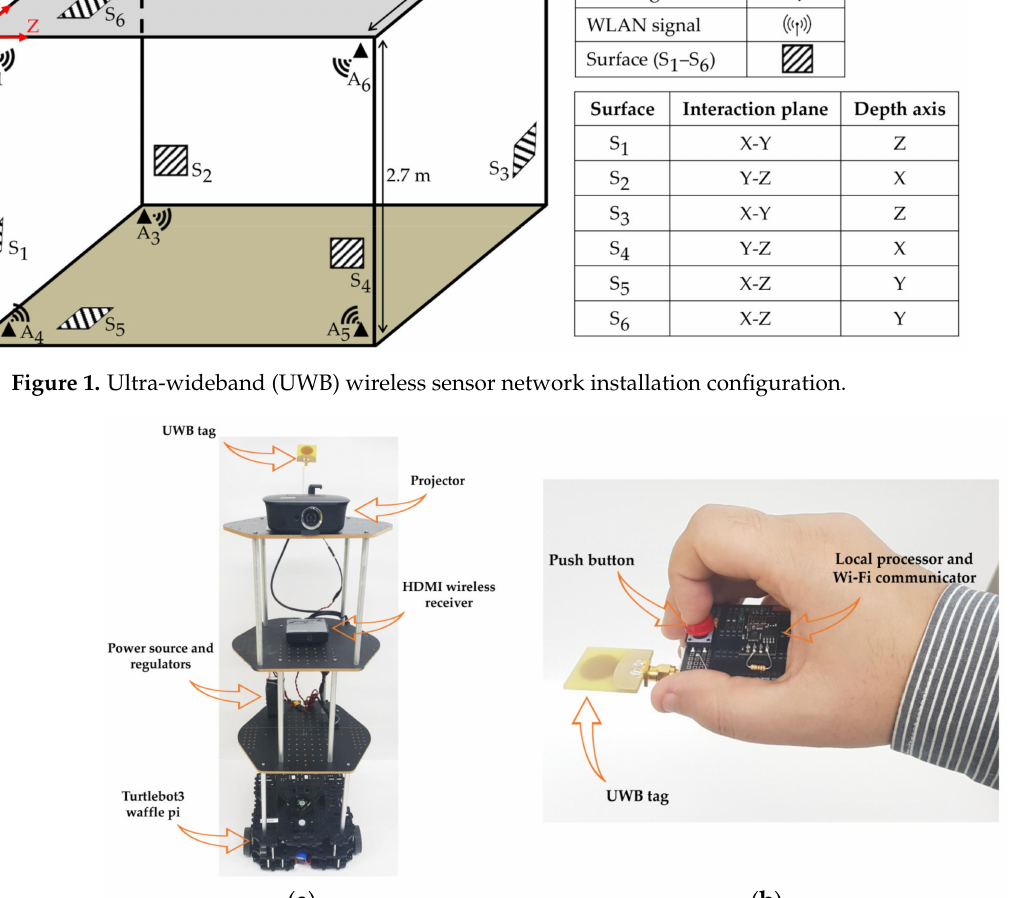
Figure 2. System hardware: ( a ) UWB-driven self-actuated projector platform; ( b ) hand-held input